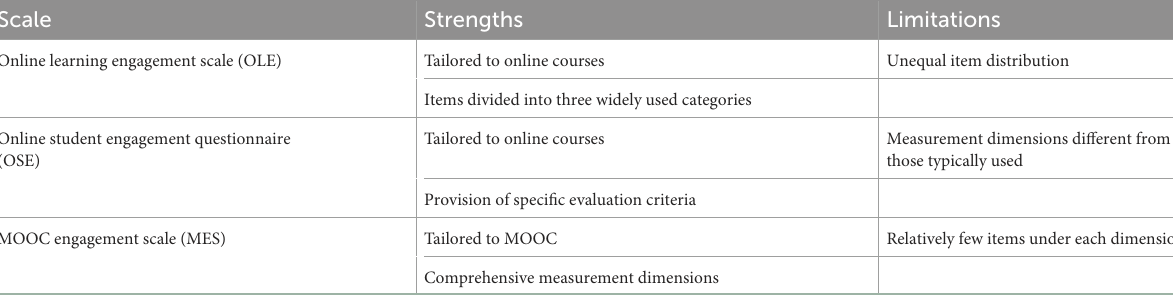
TABLE 10 Summary of the strengths and limitations of the various scales.